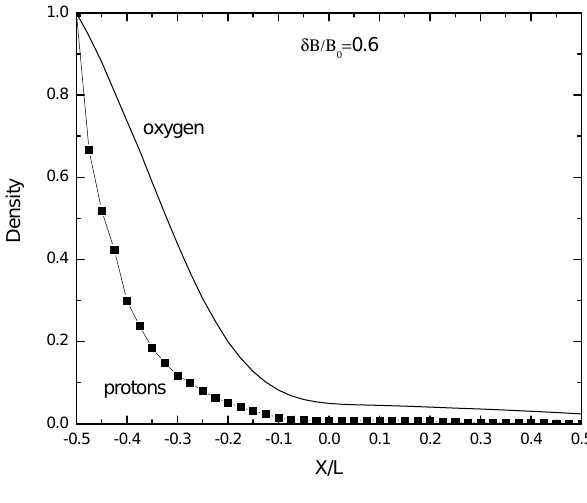
Fig. 4. Bulk velocity along z in the simulation box for proton and oxygen ions.